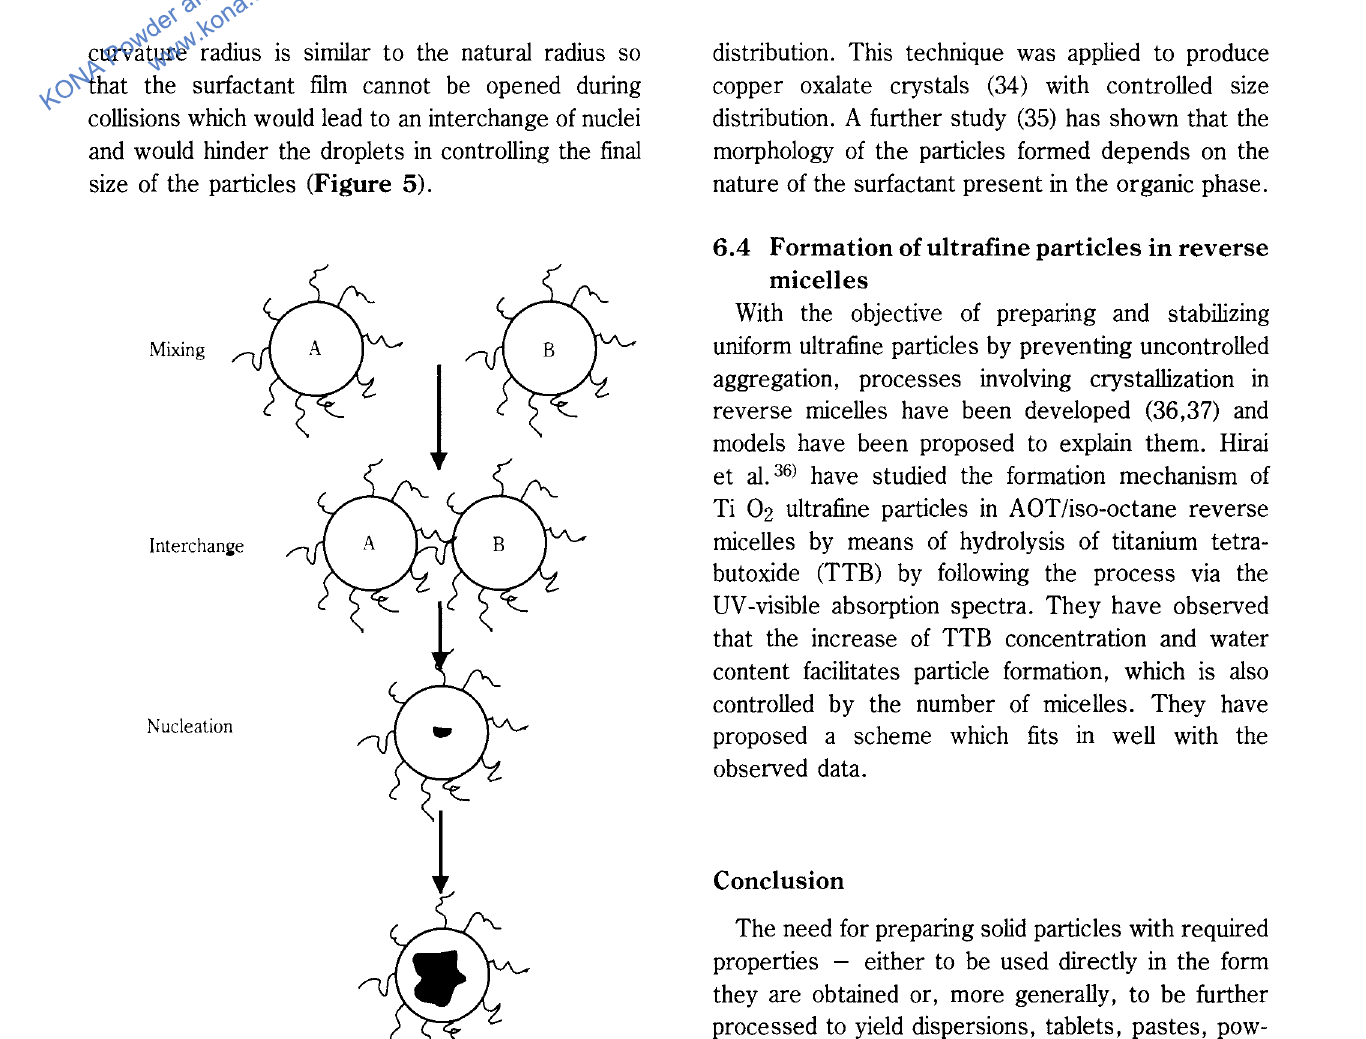
Fig. 5 Schematic process for the formation of ultrafine particles as the result of reactions in